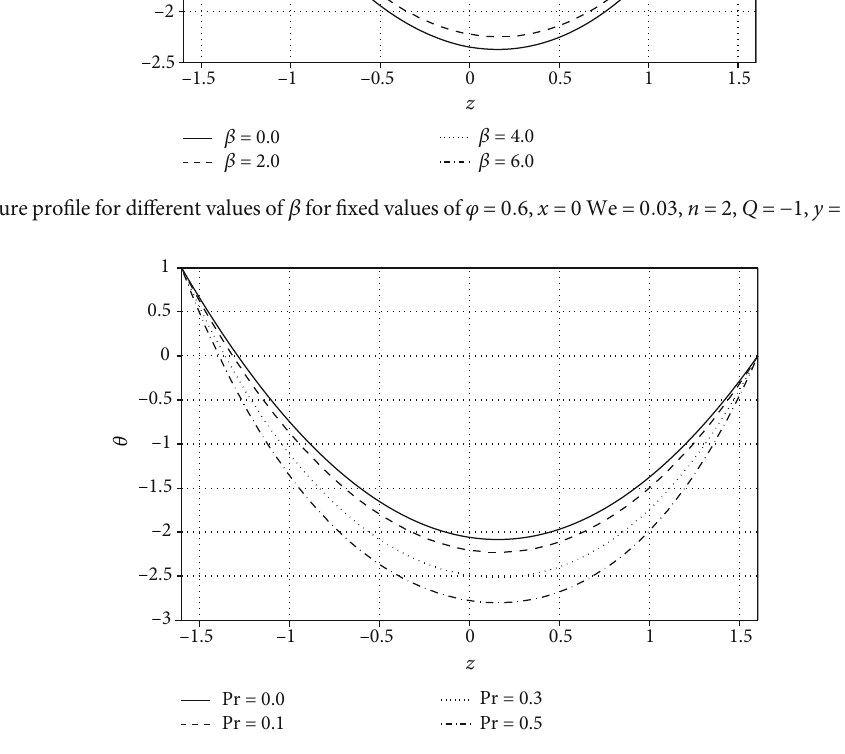
Figure 15: Temperature pro fi le for di ff erent values of Pr for fi xed values of φ = 0 : 6 , x = 0 , We = 0 : 03 , n = 2 , Q = − 1 , y = 1 , β = 0 : 2 , and Ec = 0 : 5 .